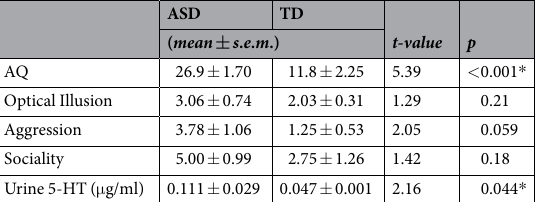
Table 1. Comparison of several factors associated with ASD, social rank, or both of them, in ASD and TD children. * Statistical significance.